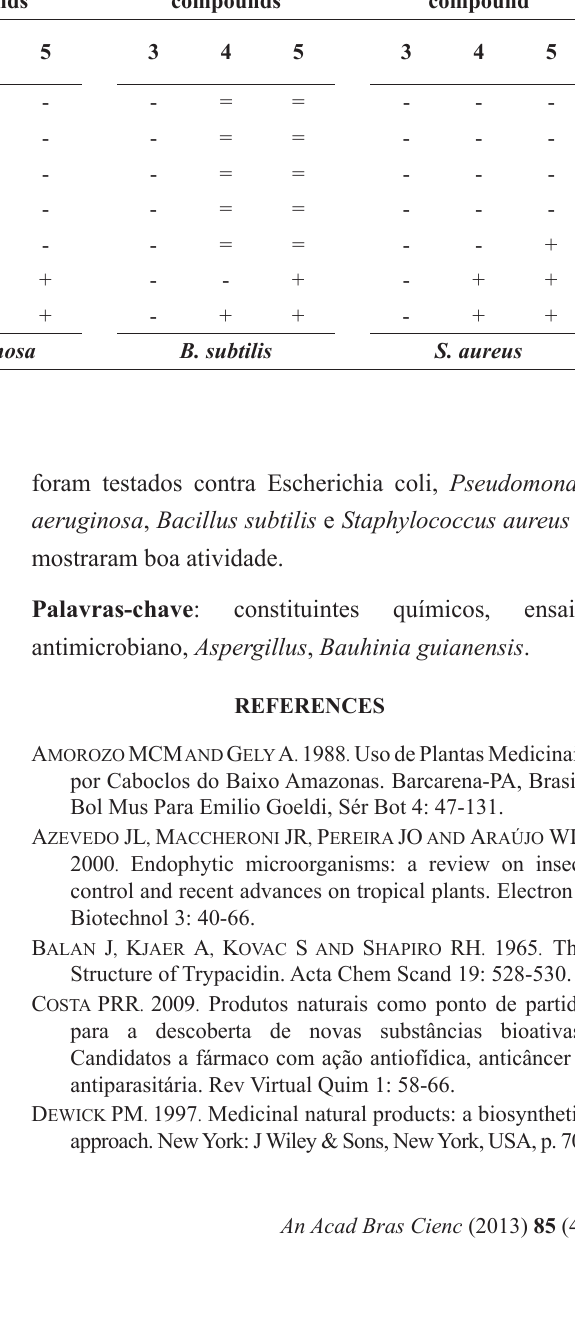
Bacteria growth behavior in the presence of compounds 3, 4 and 5 at different concentrations. compounds compounds compounds compound Concentration